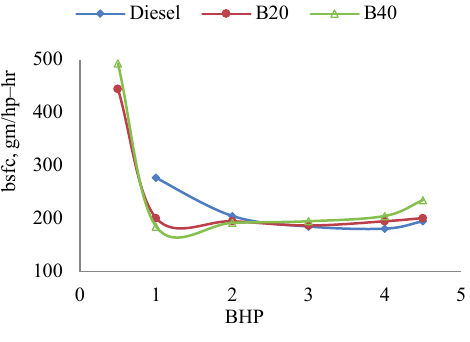
Fig. 8. Performance characteristics between BHP vs. Bsfc for Diesel and Biodiesel